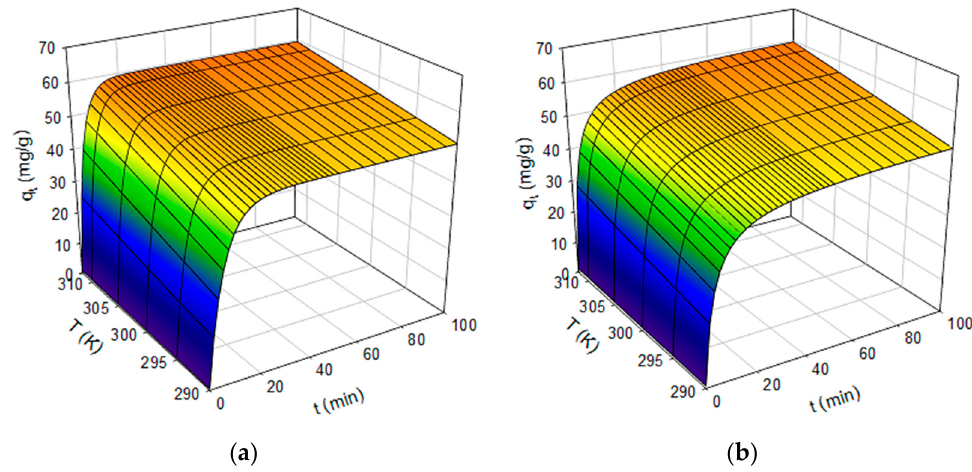
Figure 2. ( a ): Response surface graph for pseudo first-order kinetic model in Ag(I) biosorption by Rhodotorula mucilaginosa 1S1. ( b ): The same case for the pseudo second-order kinetic model.